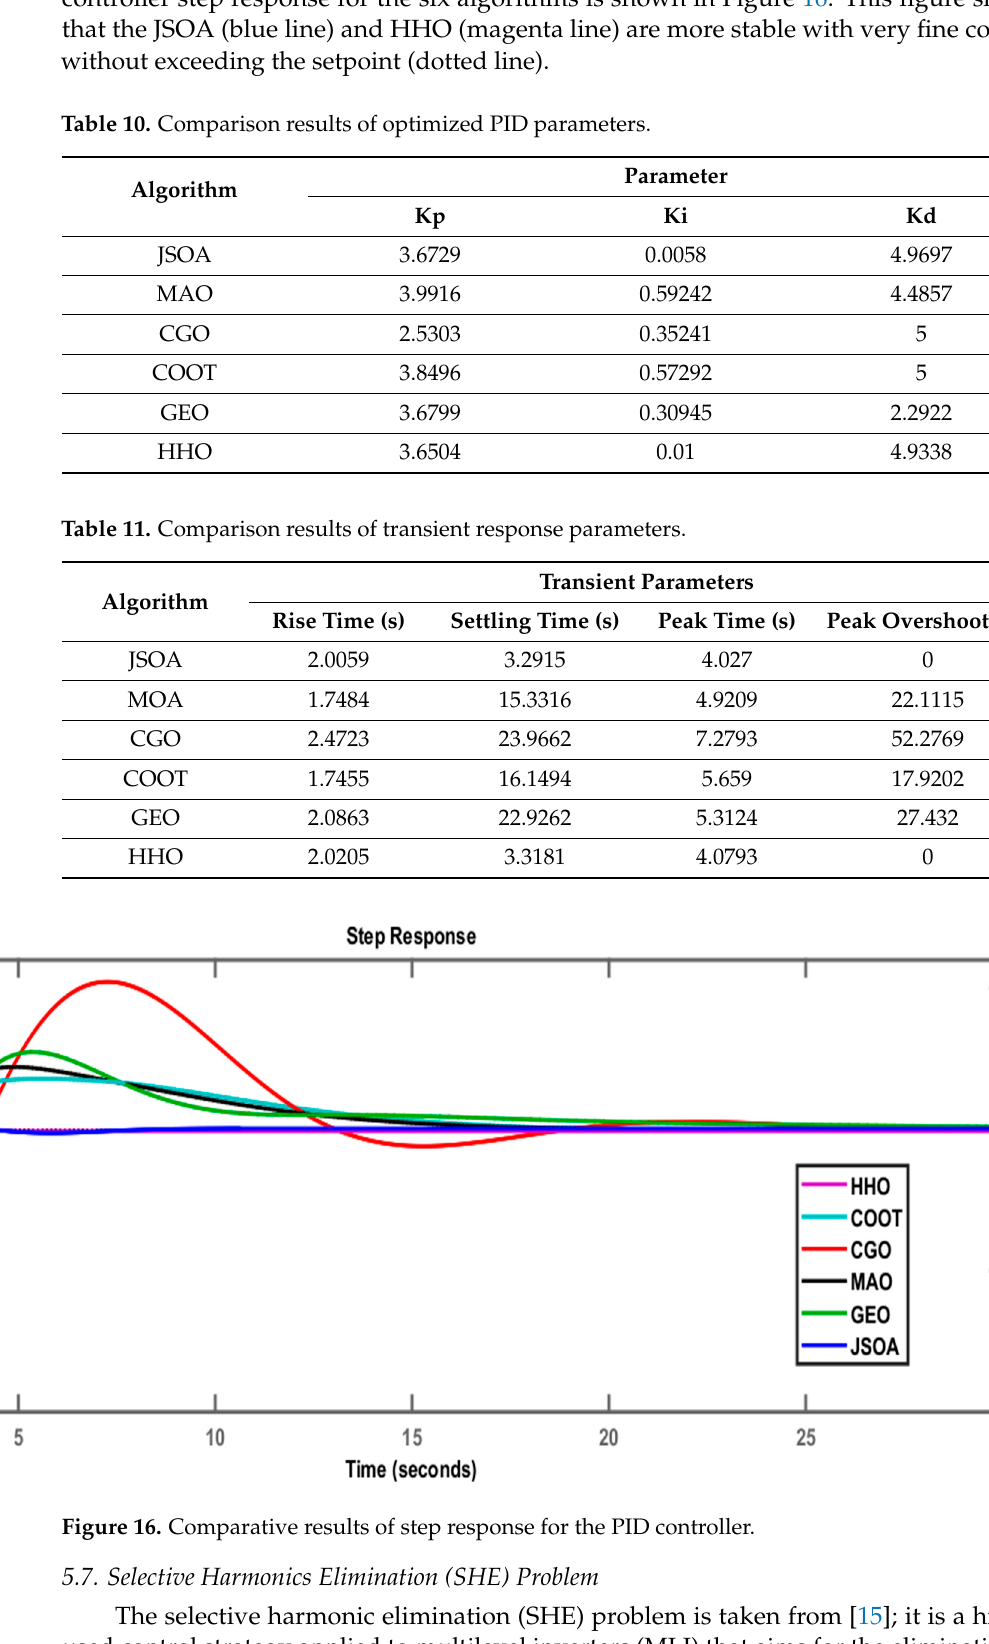
Table 10. Comparison results of optimized PID parameters.